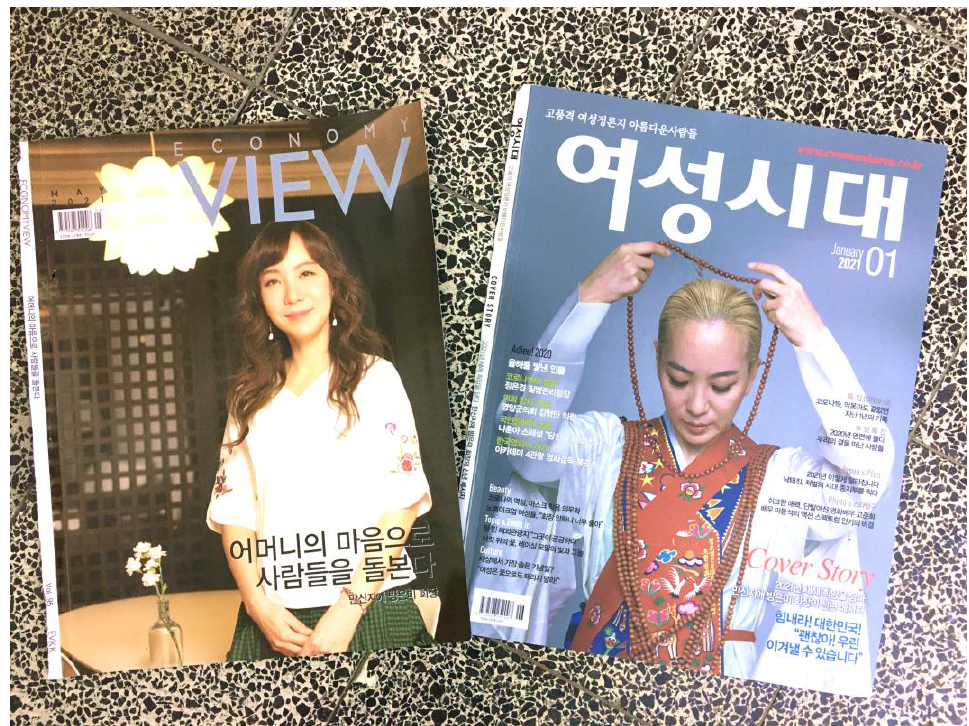
Figure 4. Recent Korean magazines featuring Pang Ŭn-mi as their cover story. July 2022, photograph by the author.